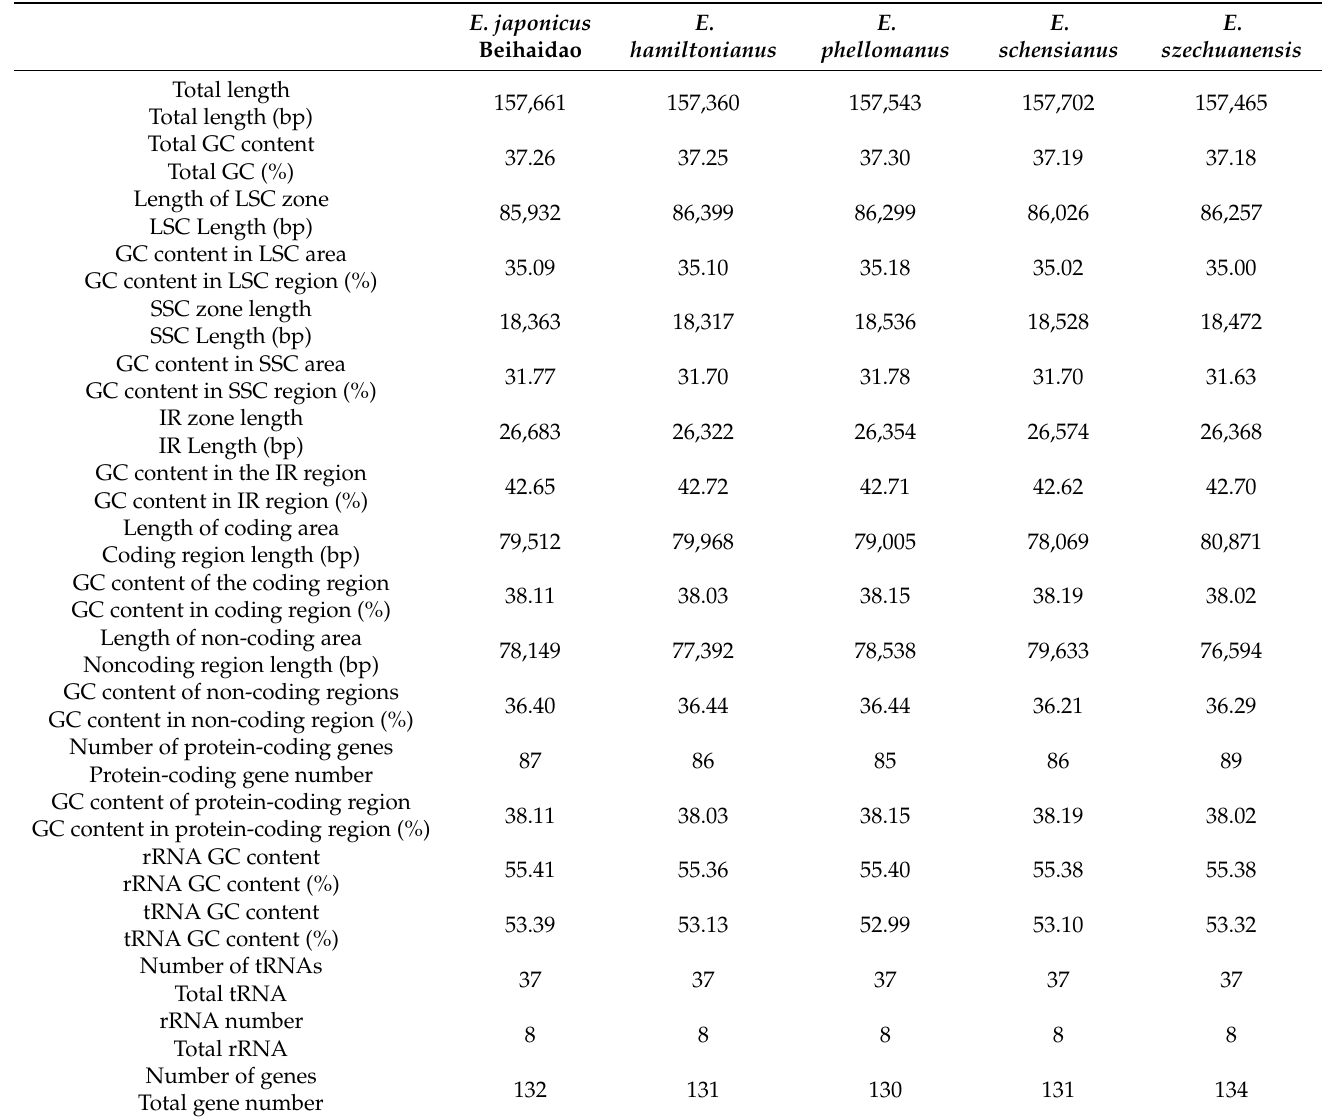
Table 4. Comparison of the chloroplast genome basic characteristics between of E. japonicus Beihaidao and four Euonymus